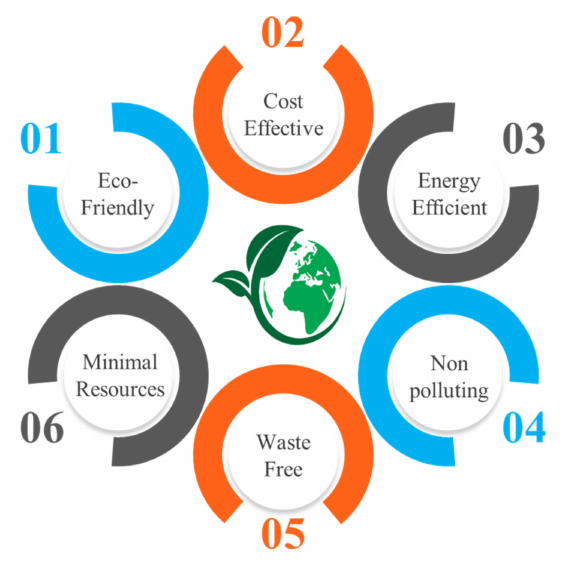
Figure 11. Benefits associated with sustainable machining.